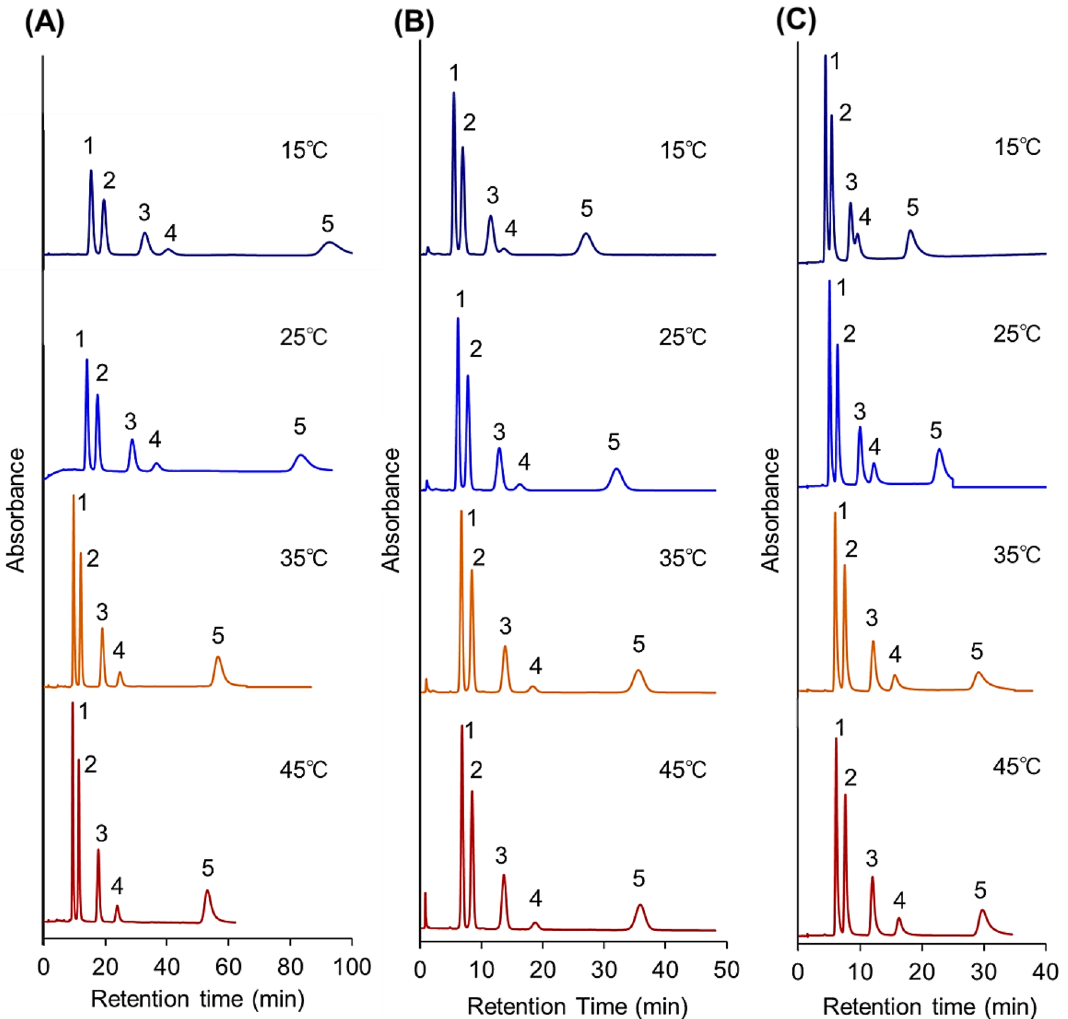
Figure 2. Chromatograms of steroids using a P(NIPAAm- co -BMA) hydrogel-modified bead column. ( A ) 7-nm pore-diameter beads, ( B ) 12-nm pore-diameter beads, and ( C ) 30-nm pore-diameter beads as base materials. The mobile phase was pure water, and the elution of the analytes was monitored at 254 nm at a mobile- phase flow rate of 1.0 min/L. Peak 1 = hydrocortisone, peak 2 = prednisolone, peak 3 = dexamethasone, peak 4 = hydrocortisone acetate, and peak 5 =